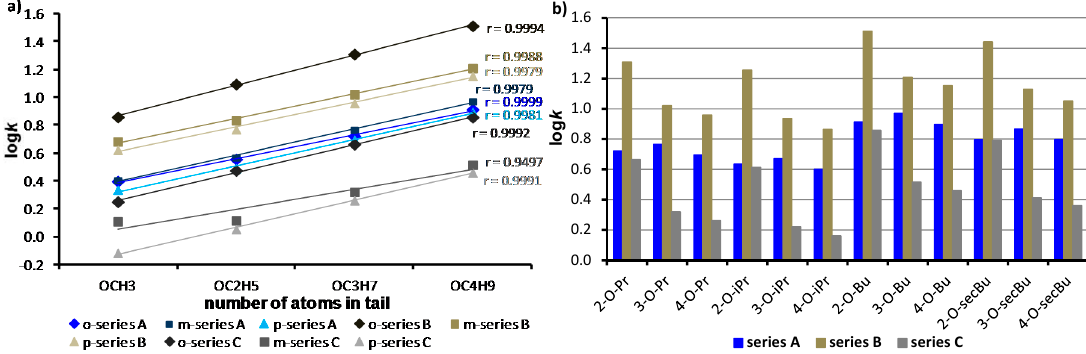
Figure 4. Comparison of experimentally determined the log k values of three discussed series of N -alkoxy substituted compounds: 3-hydroxynaphthalene-2-carboxanilides 2a – 19a (series A), 1-hydroxynaphthalene-2-carboxanilides 2b – 19b (series B), and 2-hydroxynaphthalene-1-carboxanilides 2c – 19c (series C): only unbranched alkoxy chains ( a ) and branched alkoxy chains and their unbranched isomers ( b ). Table 4. Comparison of determined distributive parameters π calculated from log k for individual alkoxy substituents within an individual series of hydroxynaphthalenecarboxanilides A–C, values of distributive parameters π expressed as means ± SD and parameters π of discussed alkoxy substituents obtained from literature [24] and calculated by ACD/Percepta ver. 2012. (N.F. = not found in literature).